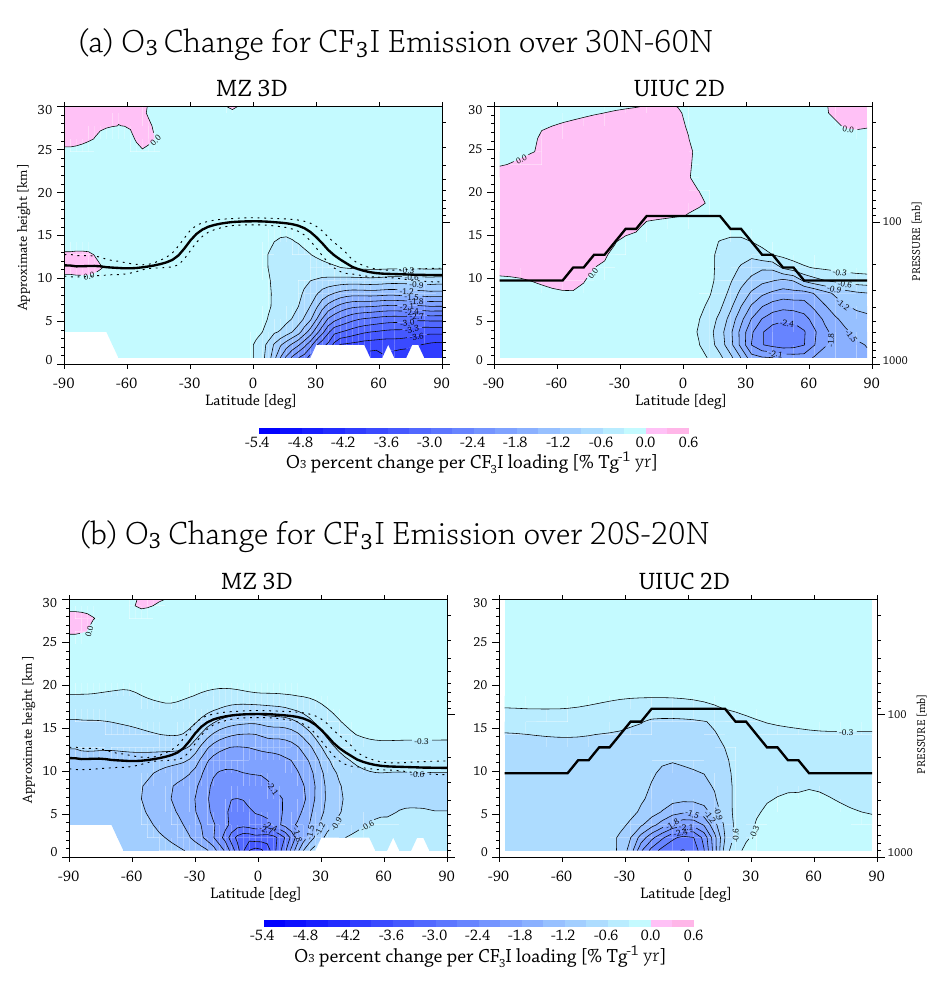
Fig. 7. Annually averaged ozone percent changes for (a) mid-latitude and (b) tropical emission scenarios relative to background atmospheric conditions without CF 3 I emissions in the unit of %Tg − 1